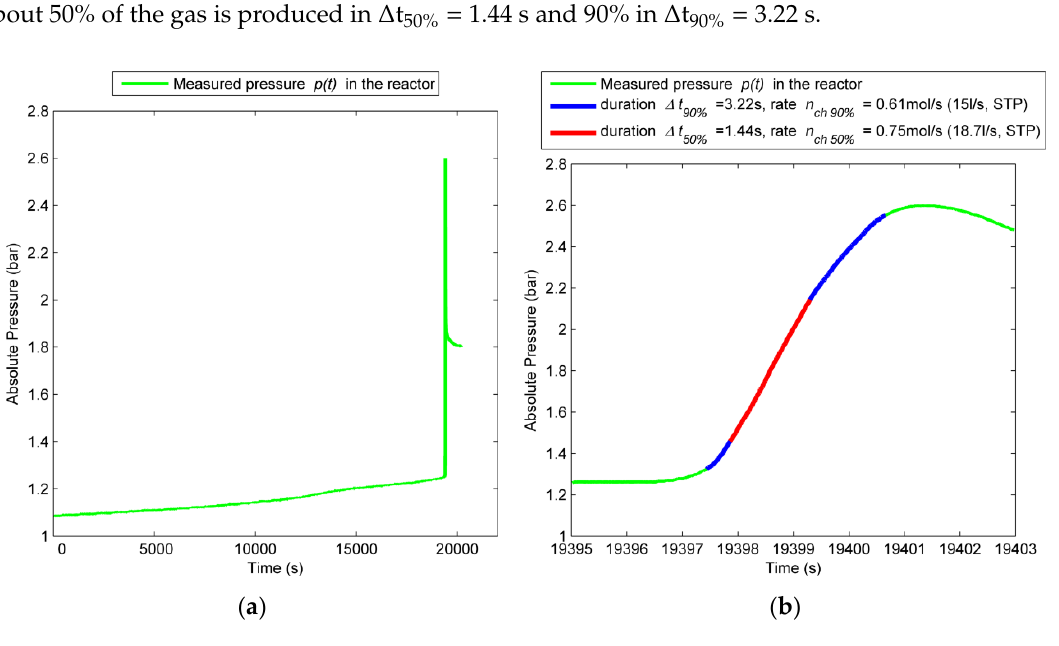
Figure 7. Absolute pressure (green) versus time of the fully charged cell ( a ) during the whole experiment and ( b ) at the TR only. The maximum pressure is reached 4 s after the TR starts. 50% of the gas is produced in 1.44 s (red line). 90% of the gas is produced in 3.22 s (blue).